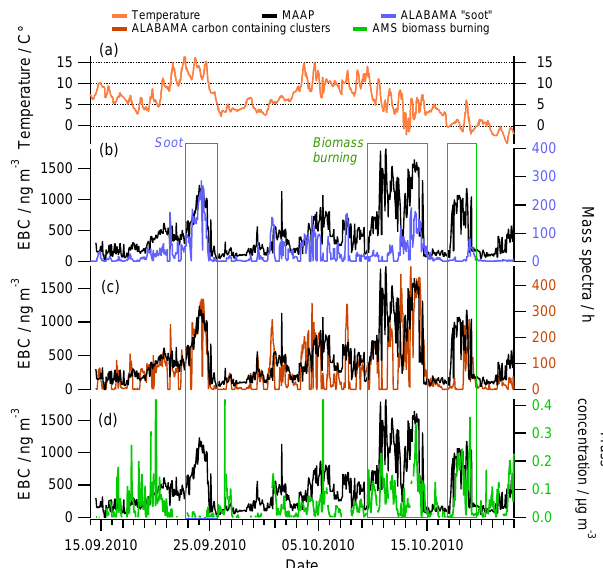
Figure 8. Time series (local time) of combustion-related parame- ters observed during HCCT-2010. (a) Temperature, (b) equivalent black carbon (EBC) together with the particle type “soot” (blue), (c) EBC along with the particle type biomass burning (brown), (d) EBC along with the biomass burning aerosol inferred from AMS data